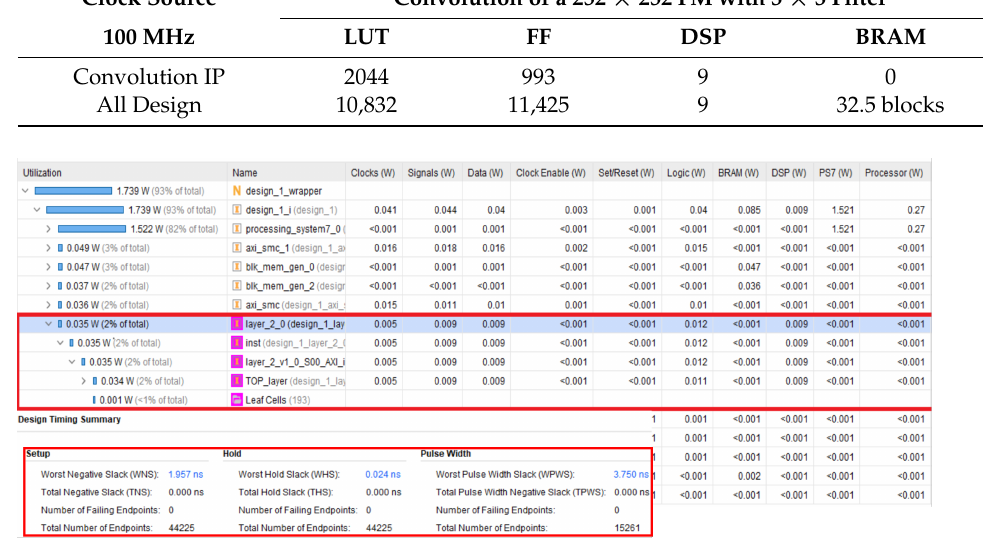
Figure 7. Resources usage and timing analysis for an image of 252 × 252 with a filter of 3 × 3, using only 1 PE.